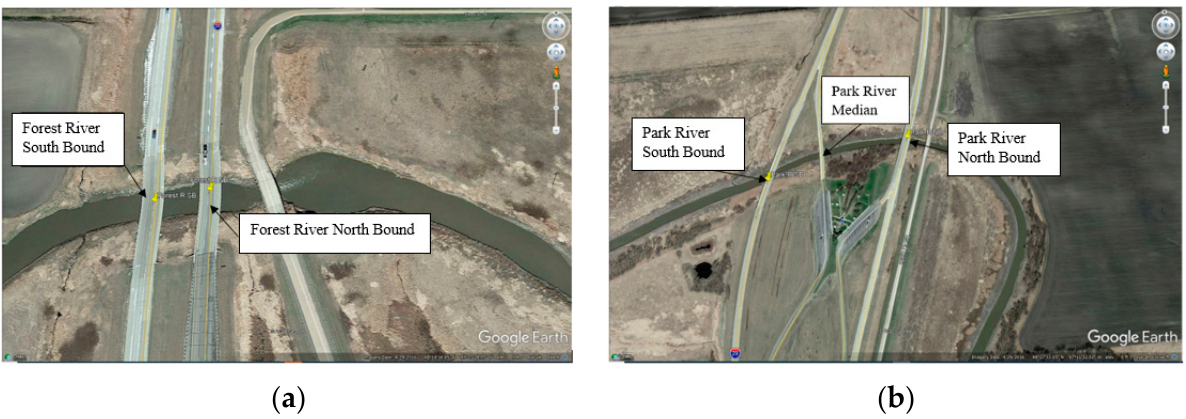
Figure 1. Layout map depicting the ( a ) Forest River bridges and ( b ) Park River bridges. (Source: Google Maps). Table 2. Summary of bridge condition data collected by